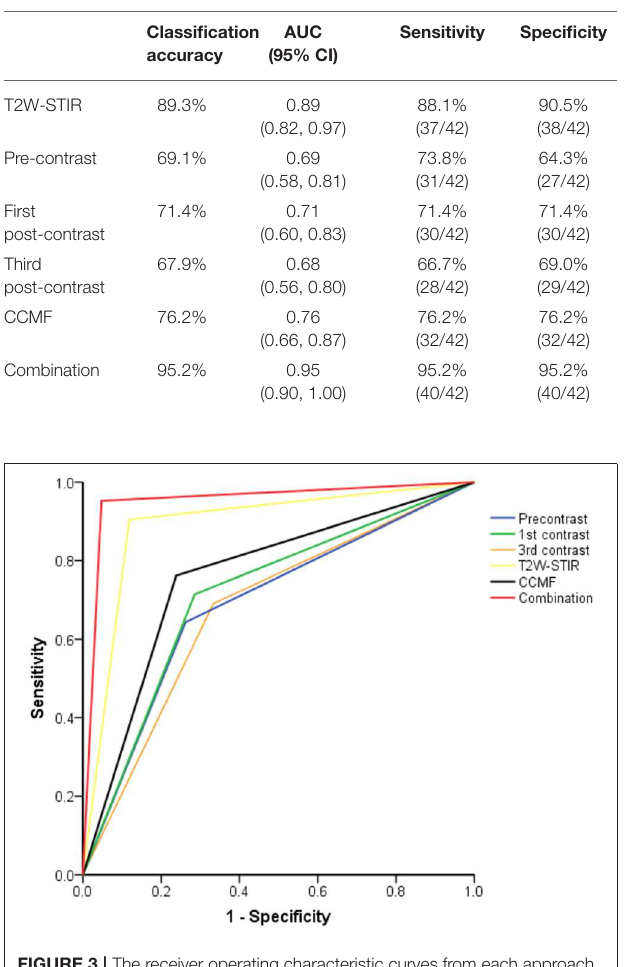
T2W-STIR was better than CCMF or texture features on T2W- STIR alone. The classification accuracy reached 95.2%, when